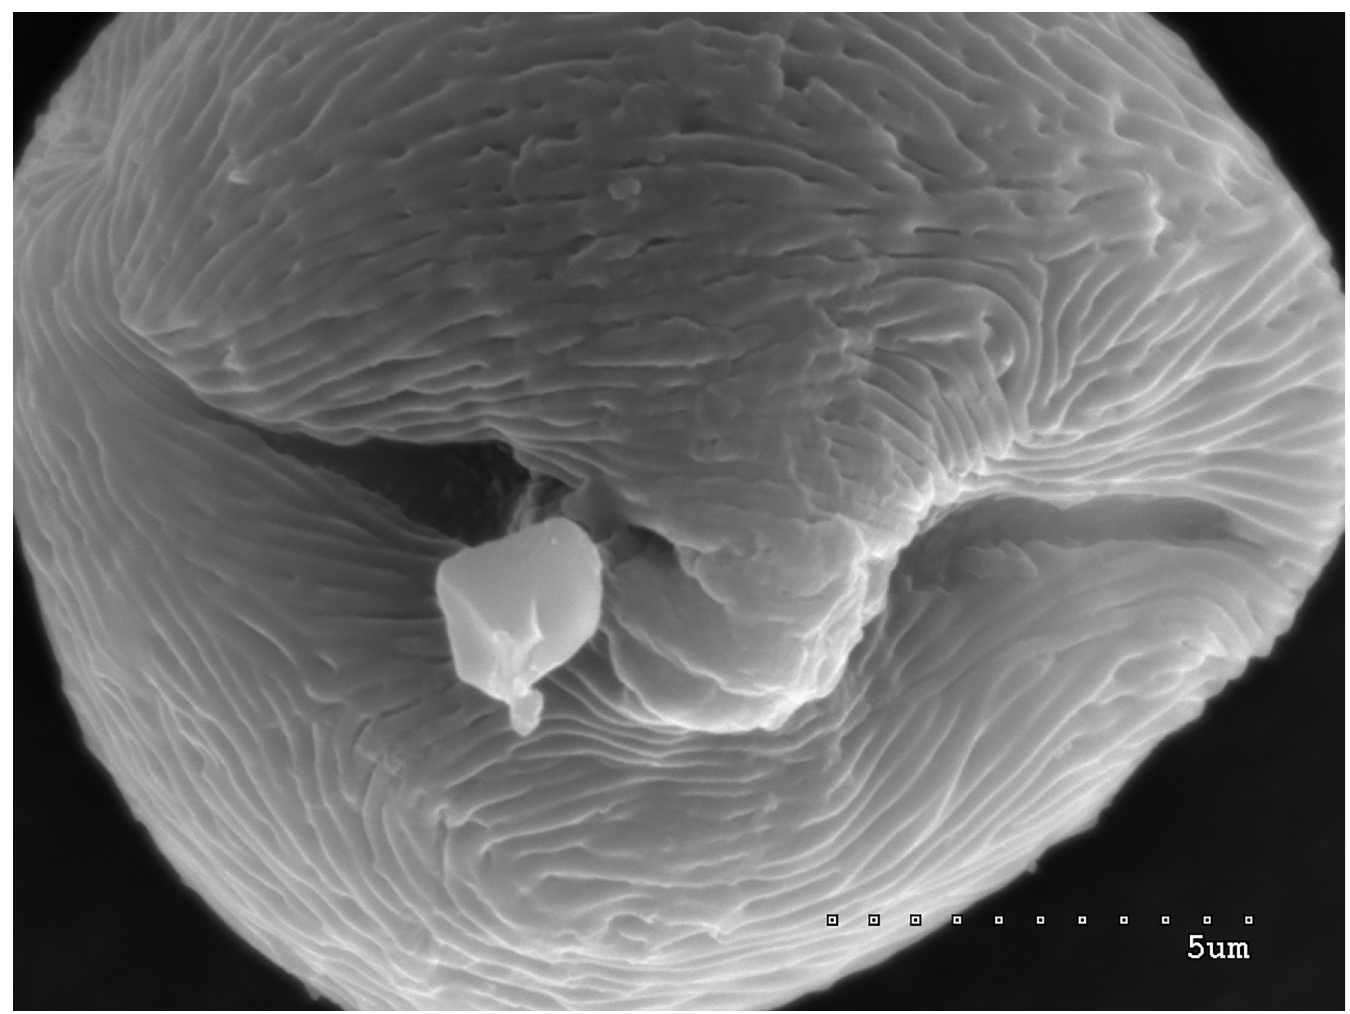
Fig 5. Colporus with operculum; granulate colpus membrane ornamentation